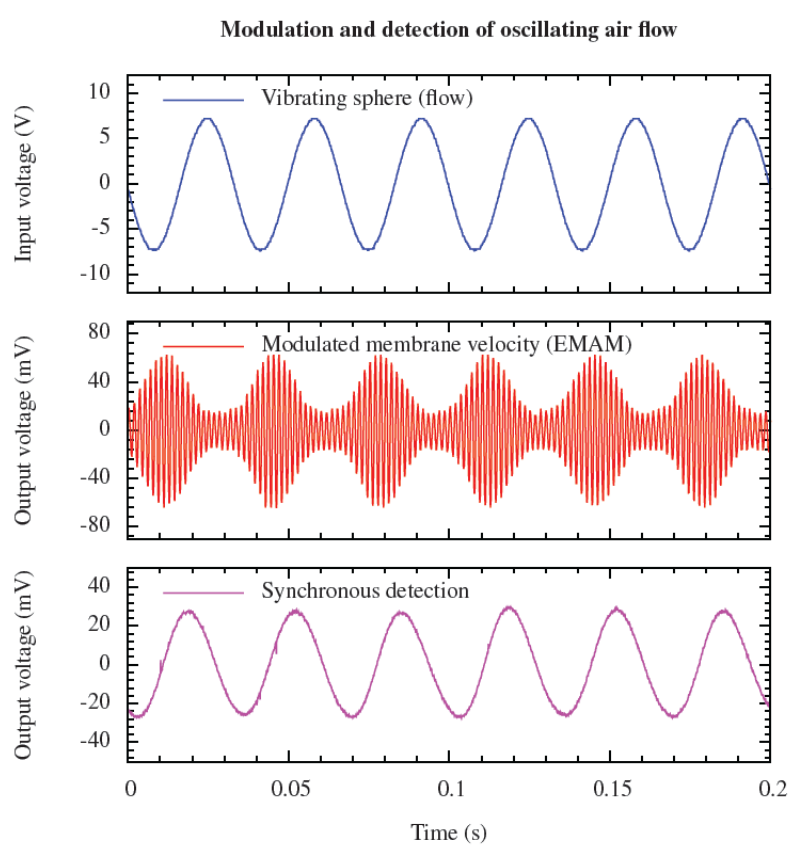
Figure 8. The applied periodic air-flow (30 Hz), the amplitude modulated membrane velocity and the synchronous detected flow signal (30 Hz) in the time-domain. The AC-bias voltage was set to 300 Hz with amplitude of 3